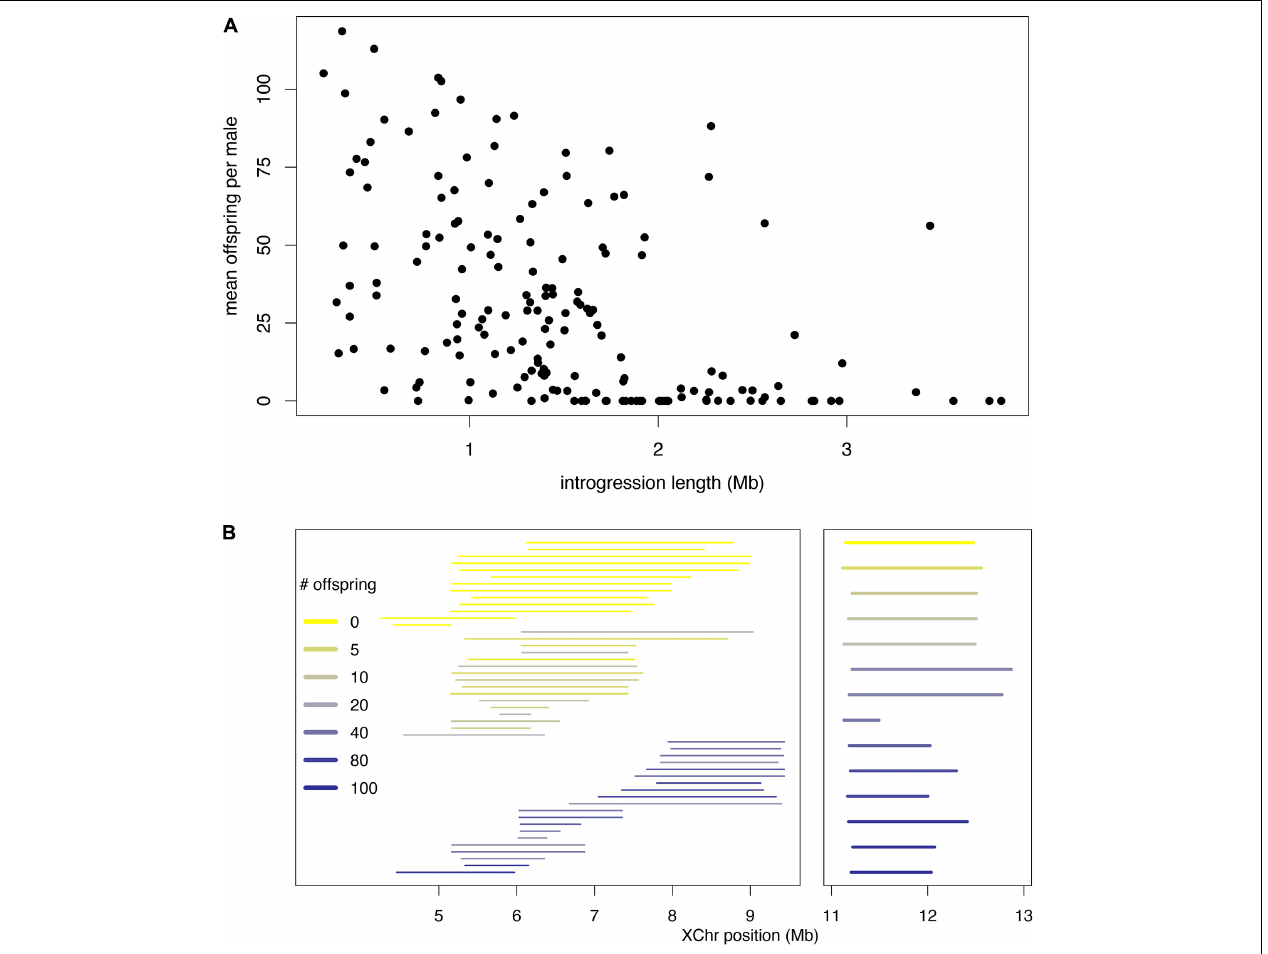
FIGURE 5 | Data from fine-scale genomic analysis of HMS. X chromosome segments from D. mauritiana were introgressed via > 25 generations of backcrossing into a D. simulans genetic background and assayed for fertility by crossing individual introgression males with three virgin D. simulans females for seven days (for data and details see Meiklejohn et al., 2018). For each introgression, ≥ 10 clonal males were phenotyped. (A) In genomic coordinates X :4–13 Mb, the fertility of all introgressions shows a strong negative correlation with length, with very few fertile introgressions > 2 Mb. (B) Introgressions consistent with the polygenic threshold model. No single D. mauritiana locus between coordinates X :5–9 Mb is sufficient to cause HMS, but longer introgressions can. The median length of sterile introgressions (top group, yellow) is 1.7-fold greater than that for fertile introgression (bottom group, blue); Wilcoxon test P ∼ 0.0001. Between both X :4–6 Mb and X :11–12 Mb (right panel), small sterile introgressions can, however, fall within overlapping, larger fertile introgressions, consistent with complex